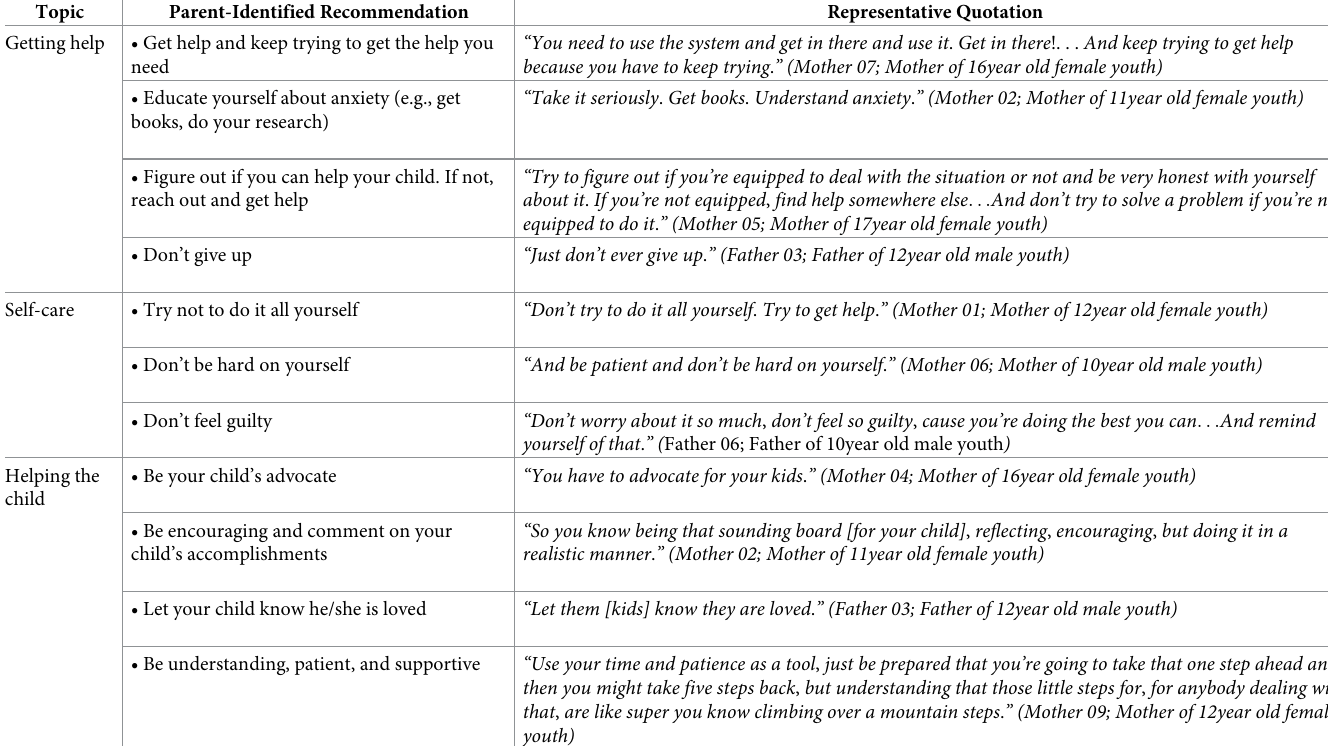
Table 3. General recommendations provided by parents for